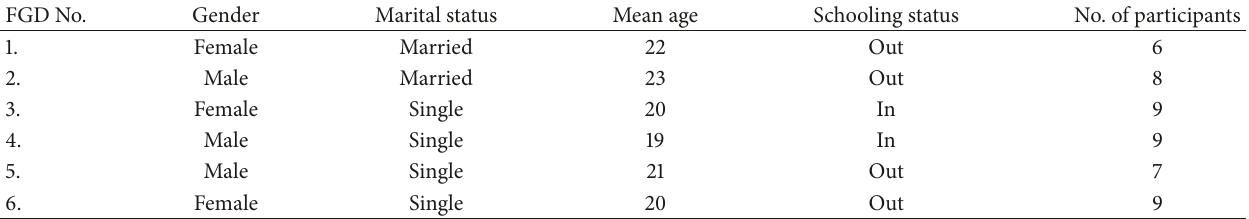
Table 1: The composition of focus group discussions for young people at health facilities, Mbarara Municipality. FGD No.